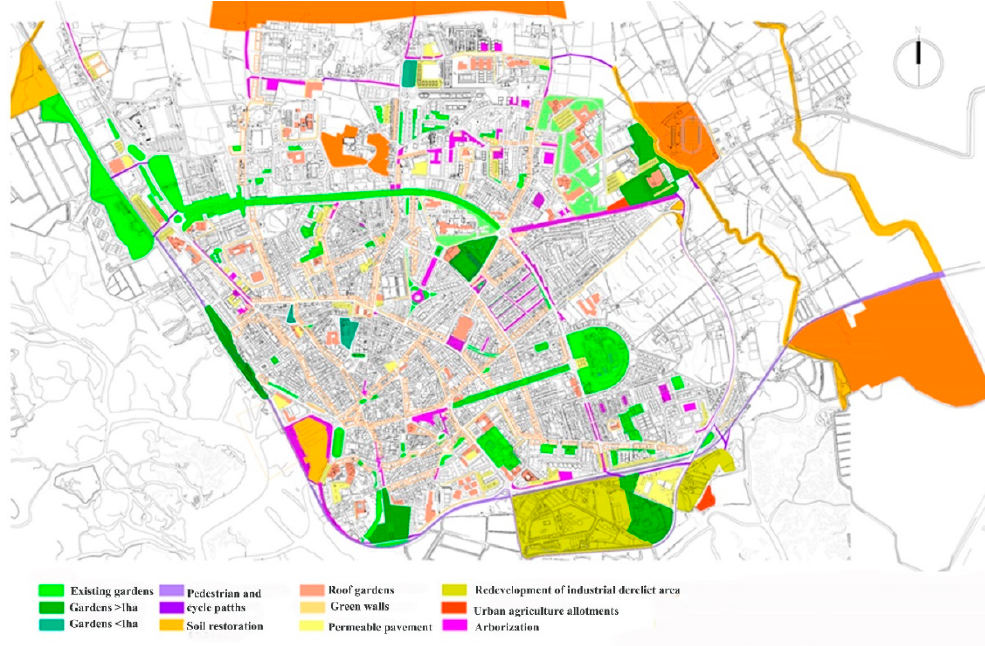
Figure 7. Proposals for new green infrastructure in Faro.